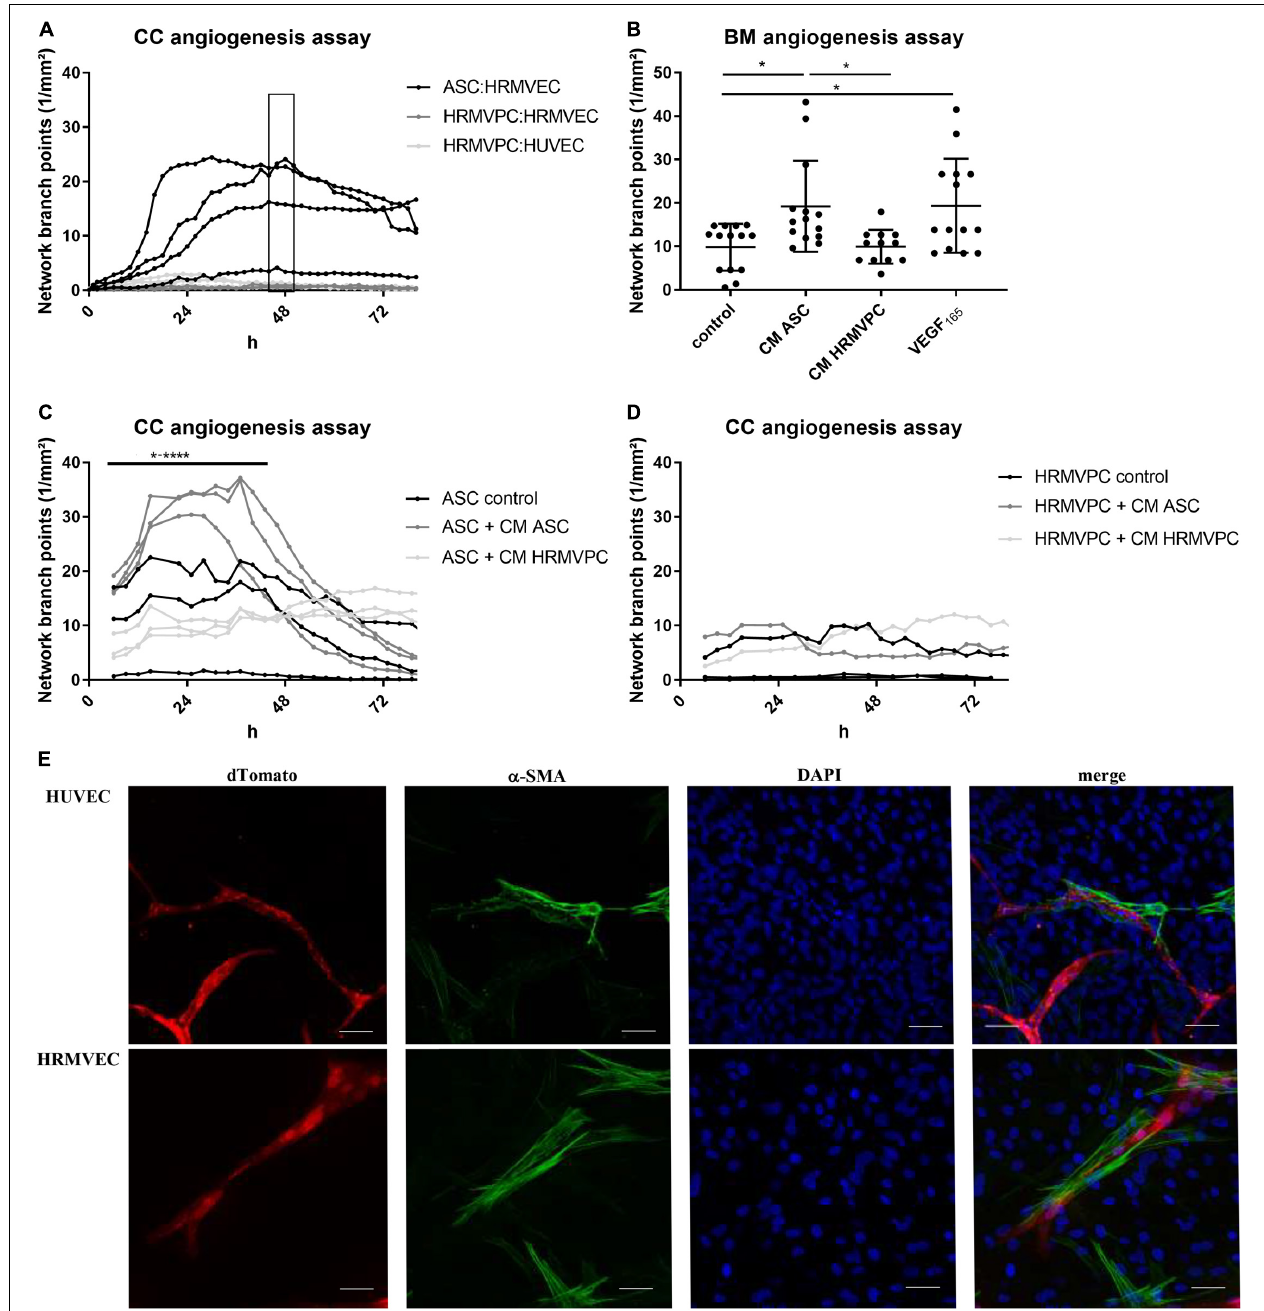
FIGURE 3 | Pro-angiogenic activity discriminates human adipose-derived stromal cells (ASC) and retinal pericytes. (A) Vascular network formation in CC angiogenesis assay using network branch point metrics (1/mm 2 ) of ASC/human retinal microvascular endothelial cells (HRMVEC), human retinal microvascular pericytes (HRMVPC)/HRMVEC, and HRMVPC/human umbilical vein endothelial cells (HUVEC) monitored using live imaging (four different ASC donors, two and three independent experiments with HRMVPC/HRMVEC and HRMVPC/HUVEC, respectively). Medium change is indicated by the box. ASC/HUVEC cocultures are not shown. (B) Vascular network formation in a BM angiogenesis assay ( n = 11 paired experiments with ASC from 11 different donors and HRMVPC from three different donors in independent experiments; * p ≤ 0.05, one-way ANOVA with Tukey’s post hoc test). (C,D) Vascular network formation in CC angiogenesis assay, adding 1 / 4 ECGM-2 as control or CC angiogenesis assay-derived CM ASC or CM HRMVPC to ASC/HRMVEC (C) or HRMVPC/HRMVEC (D) cocultures ( n = 3, with three different ASC donors, independent experiments for two HRMVPC donors; * p ≤ 0.05 to **** p ≤ 0.0001, two-way RM-ANOVA with Tukey’s post hoc test). (E) Representative images showing the expression of α -smooth muscle actin ( α -SMA) in ASC/EC cocultures (dTomato EC, red; α -SMA green; DAPI, blue nuclear counter stain and merge). Scale bar, 50 µ m.